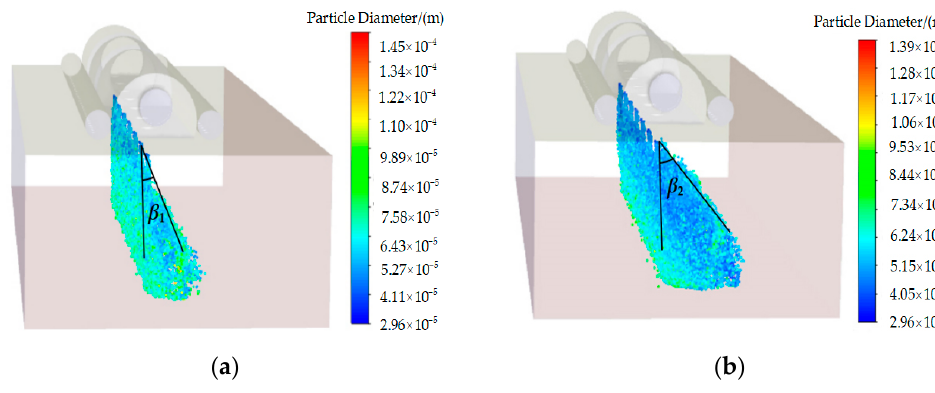
Figure 10. Droplet spatial distribution with different crosswind speed: 2 m/s ( a ); 4 m/s ( b ).